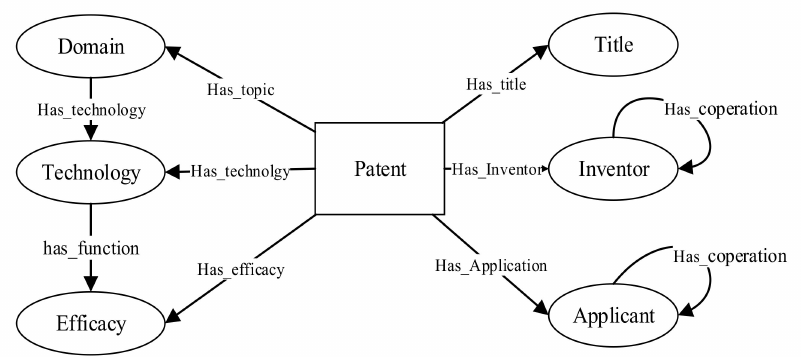
Figure 1. Patent TKG.